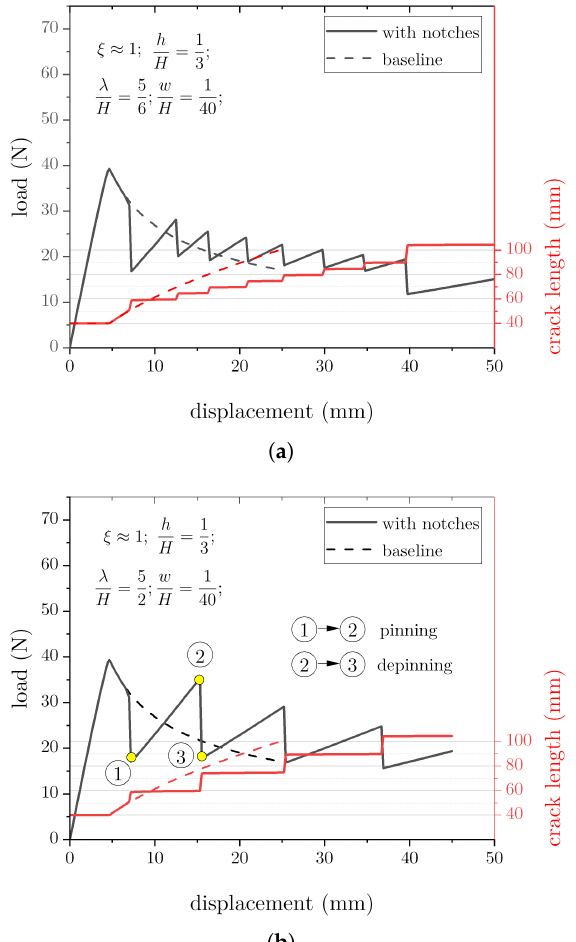
Figure 4. Load–displacement and crack length data for DCB adhesive joints with varying notch spacing. ( a ) λ / H = 5/6; ( b ) λ / H =